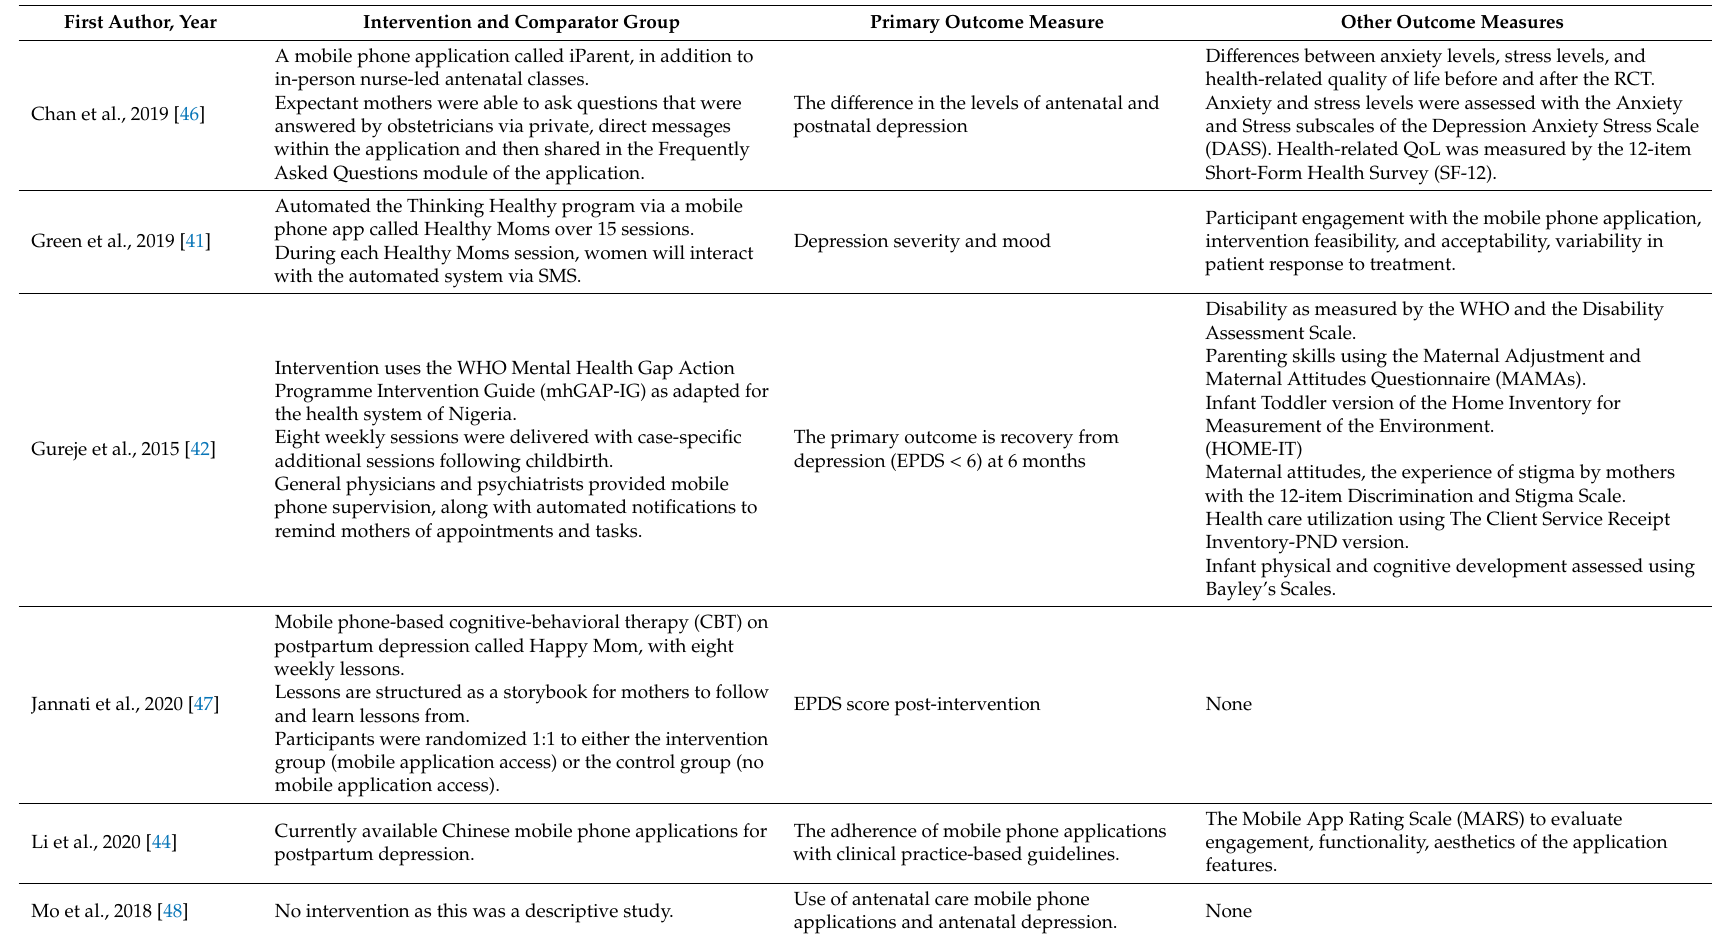
Table 3. Data extraction: